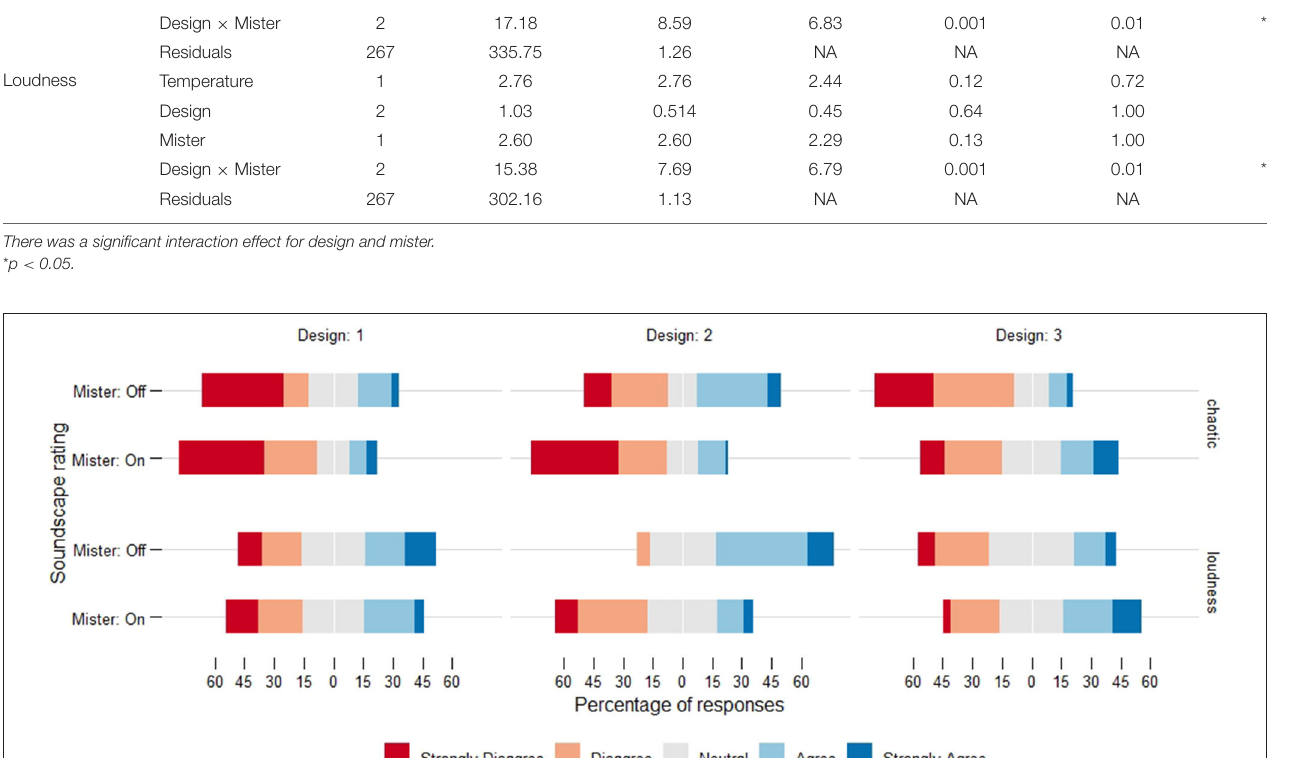
TABLE 6 | Results from the factorial ANCOVA for the chaotic and loudness scales. Variable Term DF Sum Sq. Mean Sq. F -Stat Pr ( > F) Adj. Pr ( > F) Chaotic